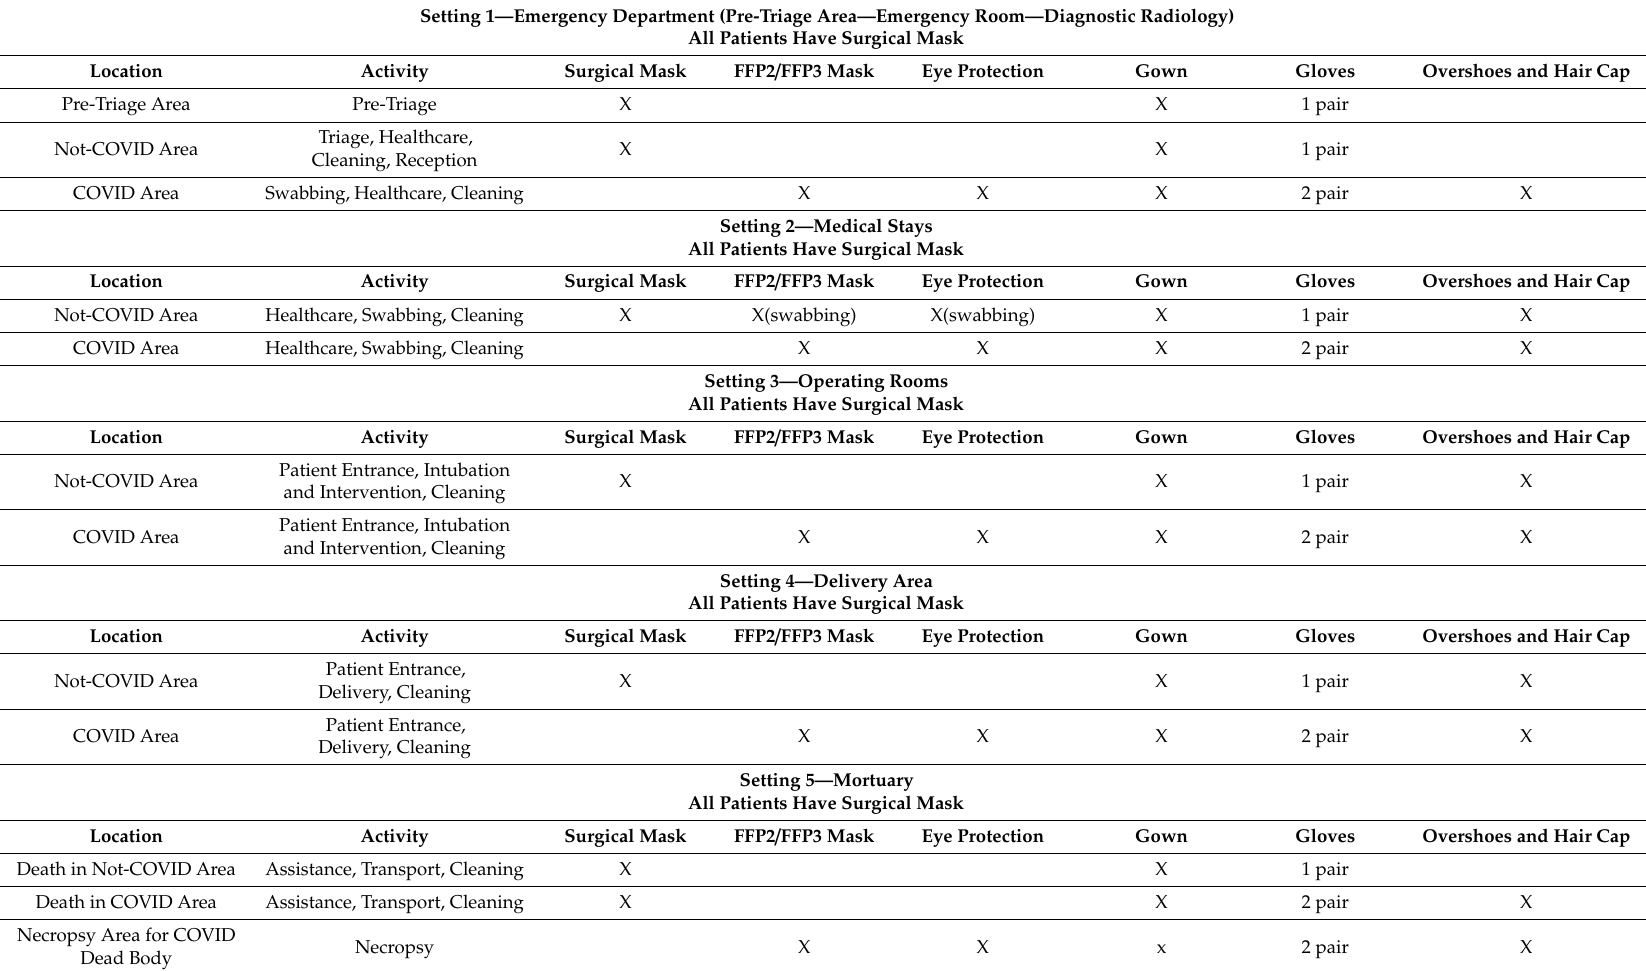
Table 1. Rational use of personal protective equipment in Coronavirus infectious disease (COVID) and not-COVID areas. Setting 1—Emergency Department (Pre-Triage Area—Emergency Room—Diagnostic Radiology) All Patients Have Surgical